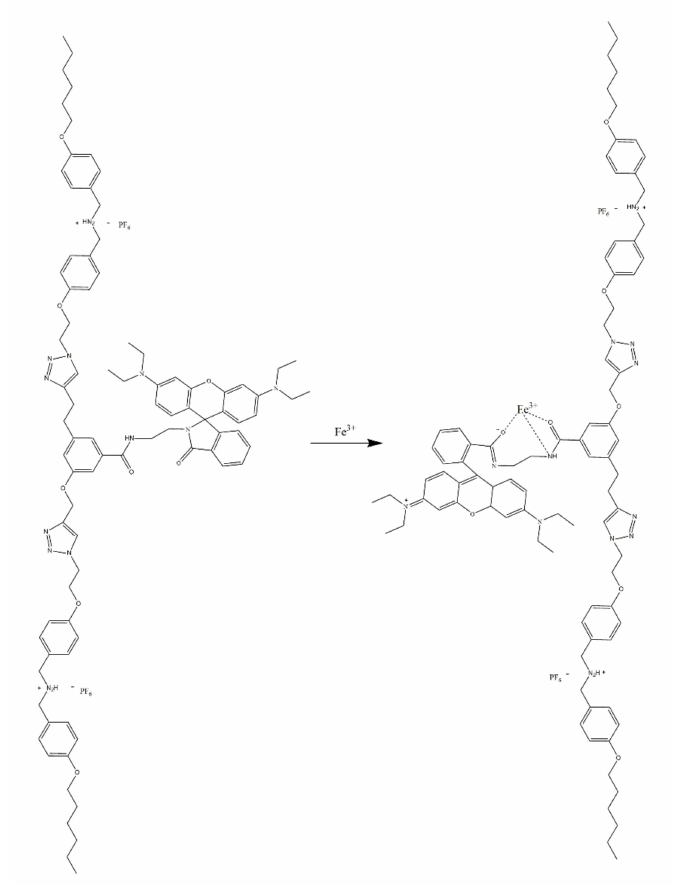
Figure 27. The possible coordination mechanism of pseudo [3]rotaxane NI-DBC/RB-DBA (Table 1, No. 35) with Fe 3+ [29].